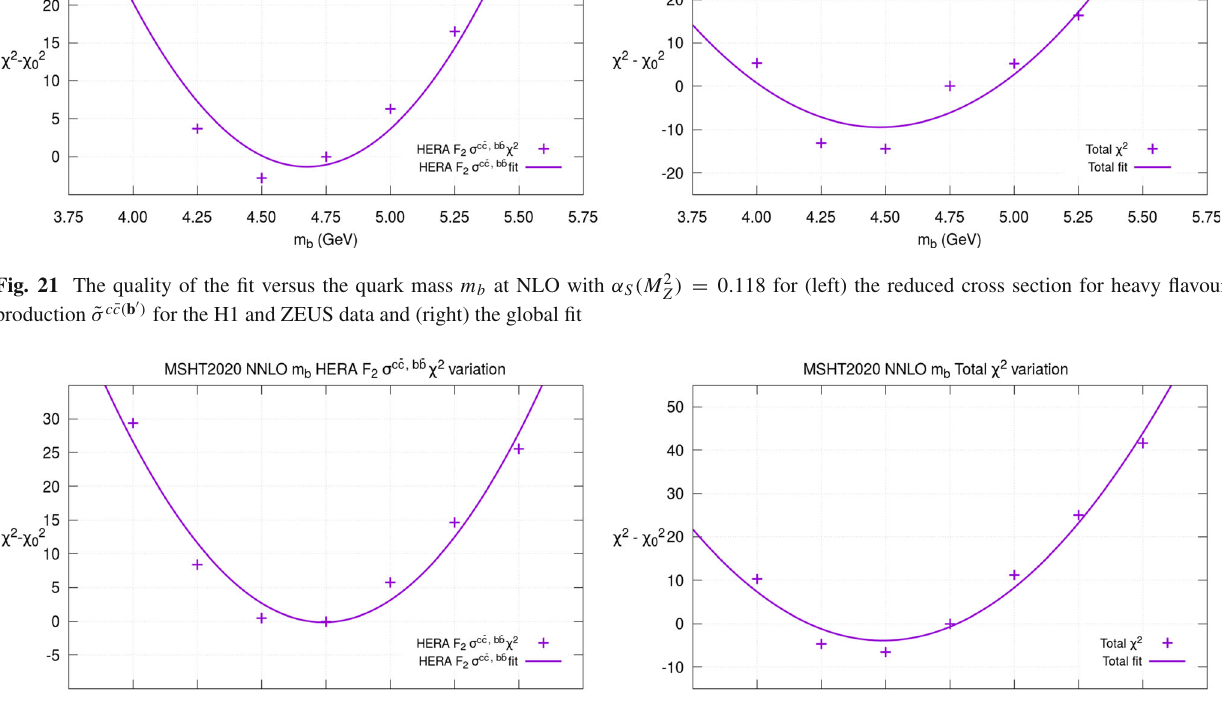
Fig. 22 The quality of the fit versus the quark mass m b at NNLO with α S ( M 2 production ˜ σ c ¯ c ( b (cid:7) ) for the H1 and ZEUS data and (right) the global